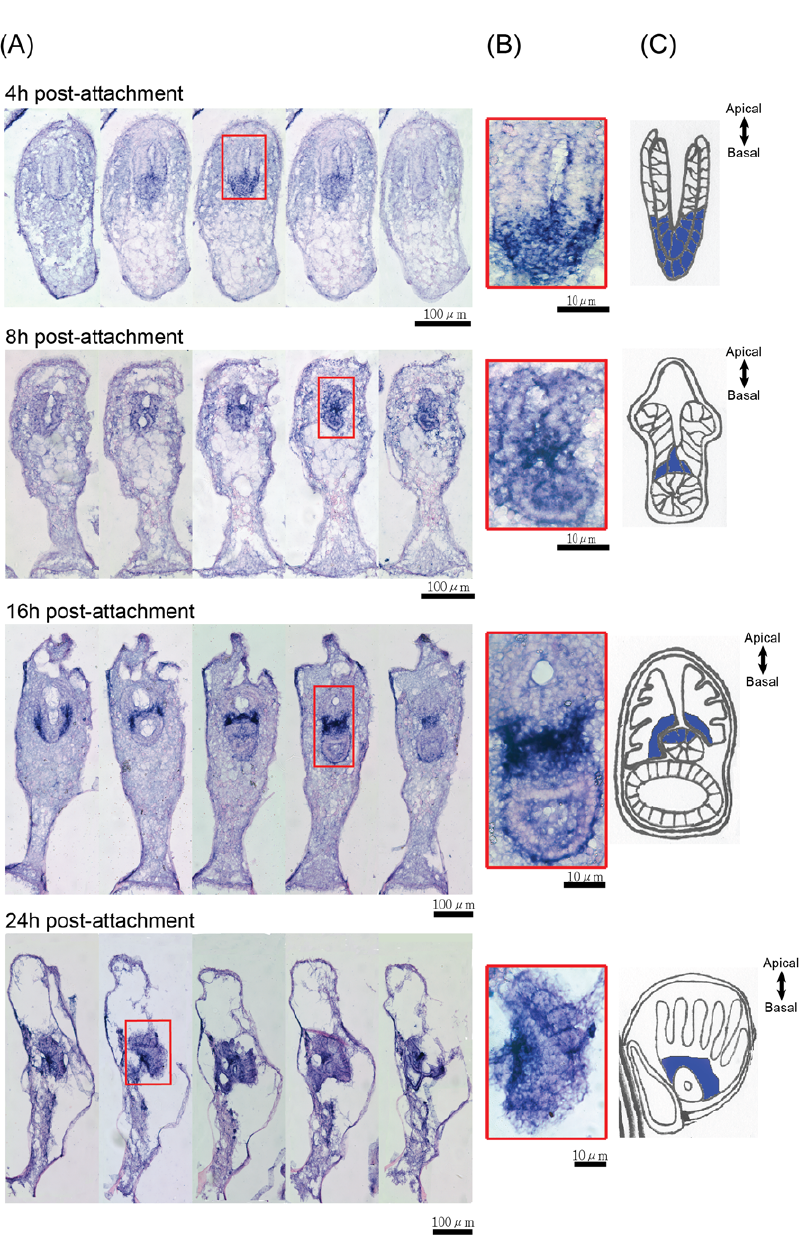
Figure 5. Expression pattern of BnsFRP in the mid- and late pre-ancestrula stages. (A) Serial sections of SISH of BnsFRP showing the Wnt inhibitor was expressed in distinct regions within the developing polypide. (B) Area highlighted in red box in (A) highlighted were captured using high power (100 6 ) objective, providing the details of BnsFRP expression in the developing polypide. (C) Portrait depicts the anatomy of the developing polypide and the expression pattern of BnsFRP , which was indicated by blue color. In the early pre-ancestrula stage (4 h post-attachment) BnsFRP was expressed in the basal blastemas. In the mid-pre-ancestrulae stage, BnsFRP is expressed at the intersection between the apical and basal blastemas (8 h post-attachment) as well as in the exterior of the stomach (16 h post-attachment). In the late pre-ancestrula stage, BnsFRP is expressed in the base of the lophophore, but not in the pharynx or stomach.